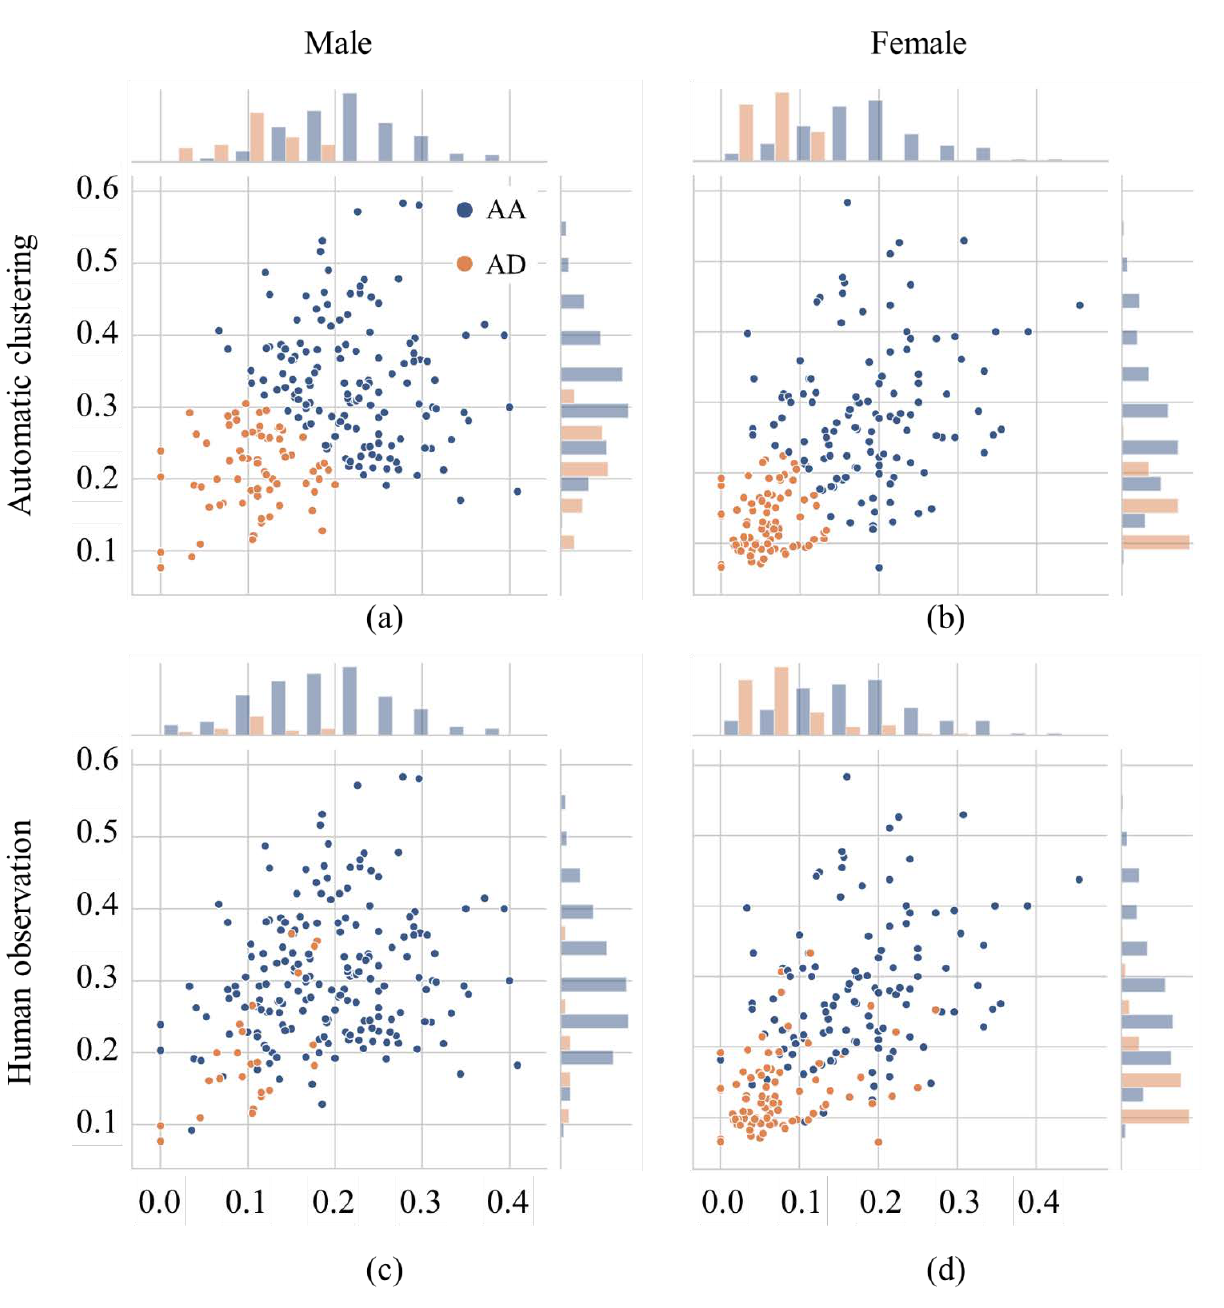
Figure 5 . The results of clustering based on the occurrence of missed shots at the third shot (horizontal axis) and the fifth shot (vertical axis). Automatic clustering denotes the results of Gaussian Mixture Model (GMM)-based clustering, and Human observation denotes the data labelled through human